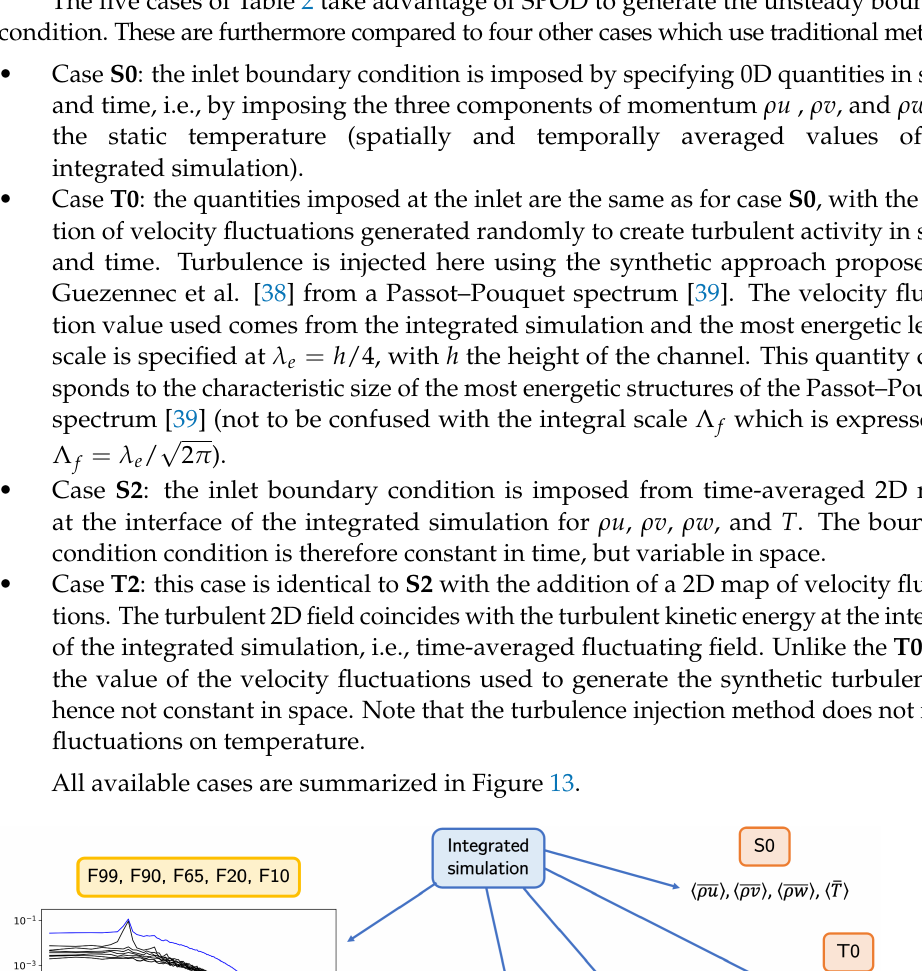
Figure 13. Summary of compared cases. The operator the operator to the spatial (cid:104)•(cid:105)